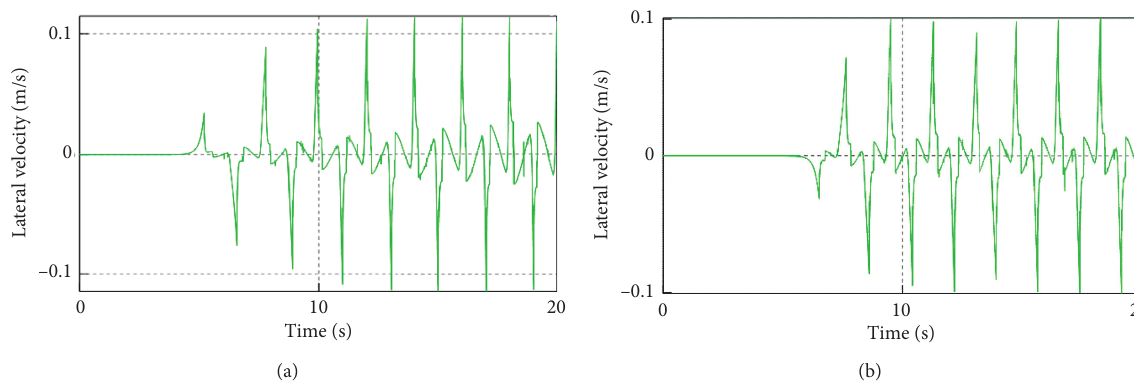
Figure 15: Changes of the lateral velocity when the center of mass is (a) 1.5m and (b) 1.1m below the axis of the driving wheel.